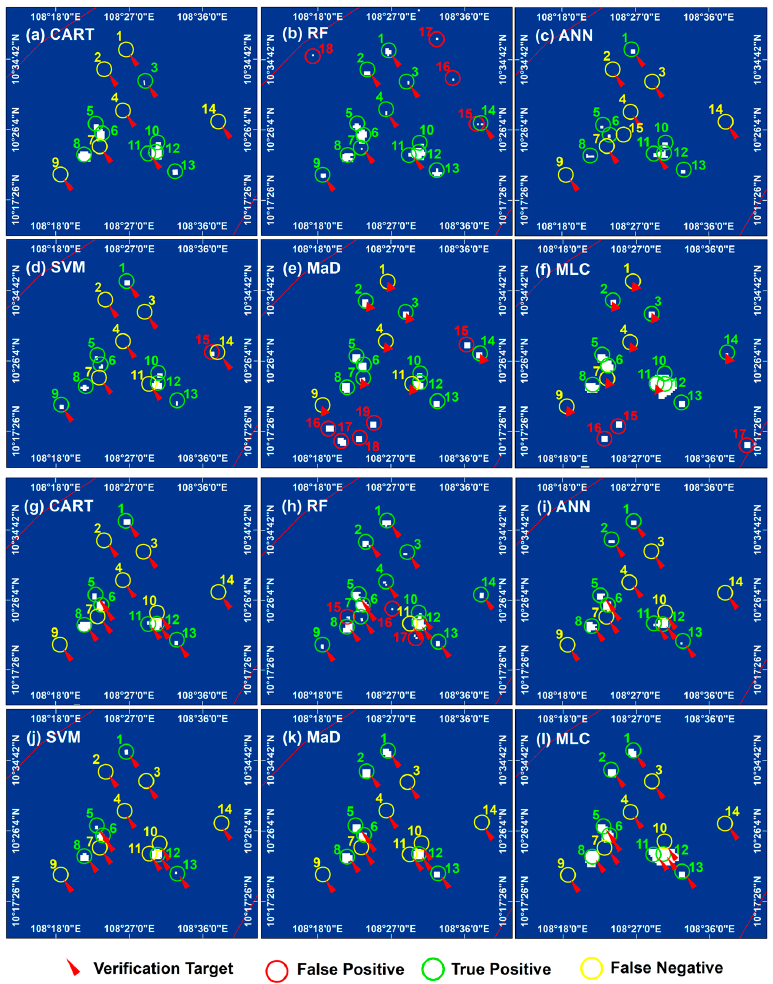
Figure 7. Extraction results of the targets in region 3, located in the Mekong Basin: ( a – f ) are the extraction results in 2016; ( g – l ) are the extraction results in 2017. Red arrows are the validation targets; green circles are the correctly extracted targets; yellow circles are the omissive targets; and red circles are the incorrectly extracted